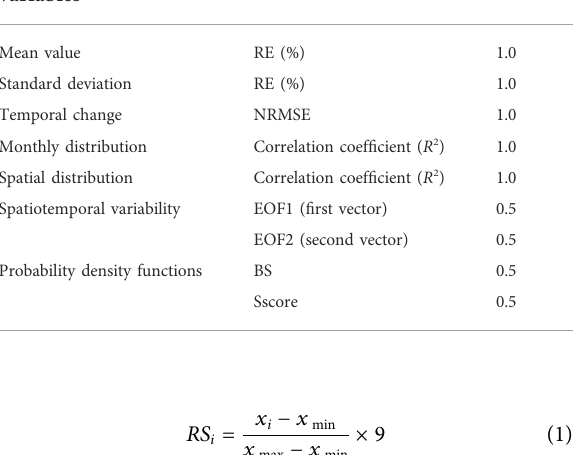
TABLE 3 Statistics of climate variables and their